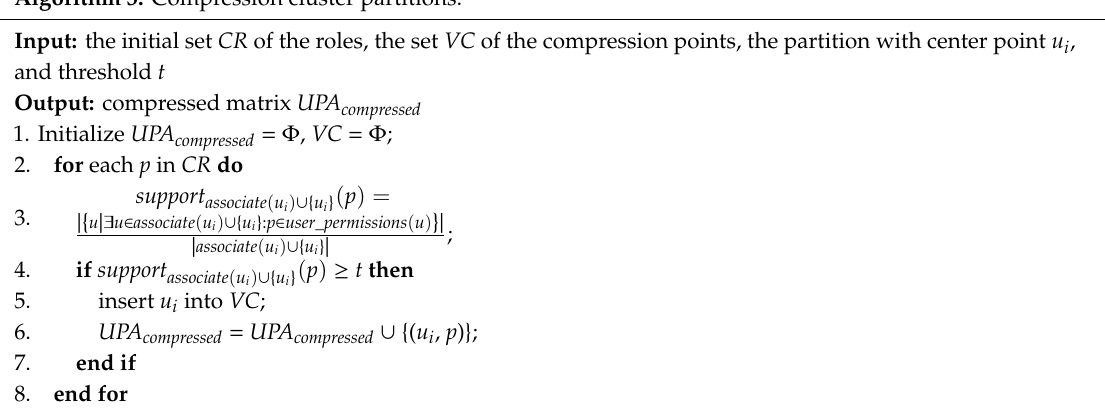
Algorithm 3. Compression cluster